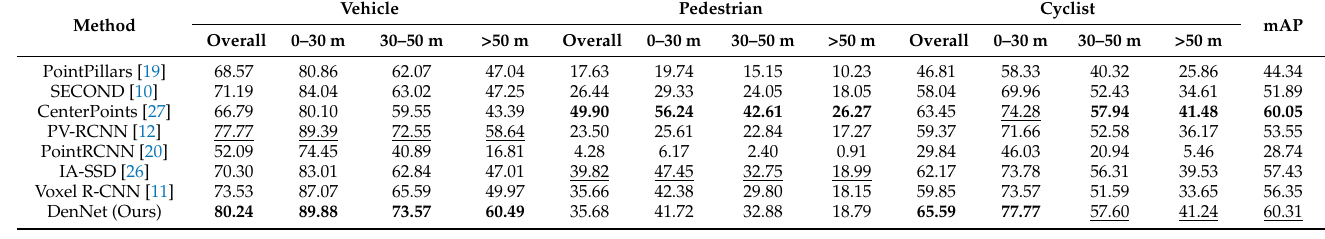
Table 3. Performance comparison on ONCE validation set. The best results are presented in bold, whereas the second-best results are underlined.